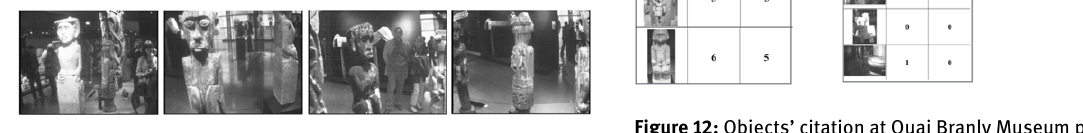
Figure 11: Examples of objects learned in Quai Branly.